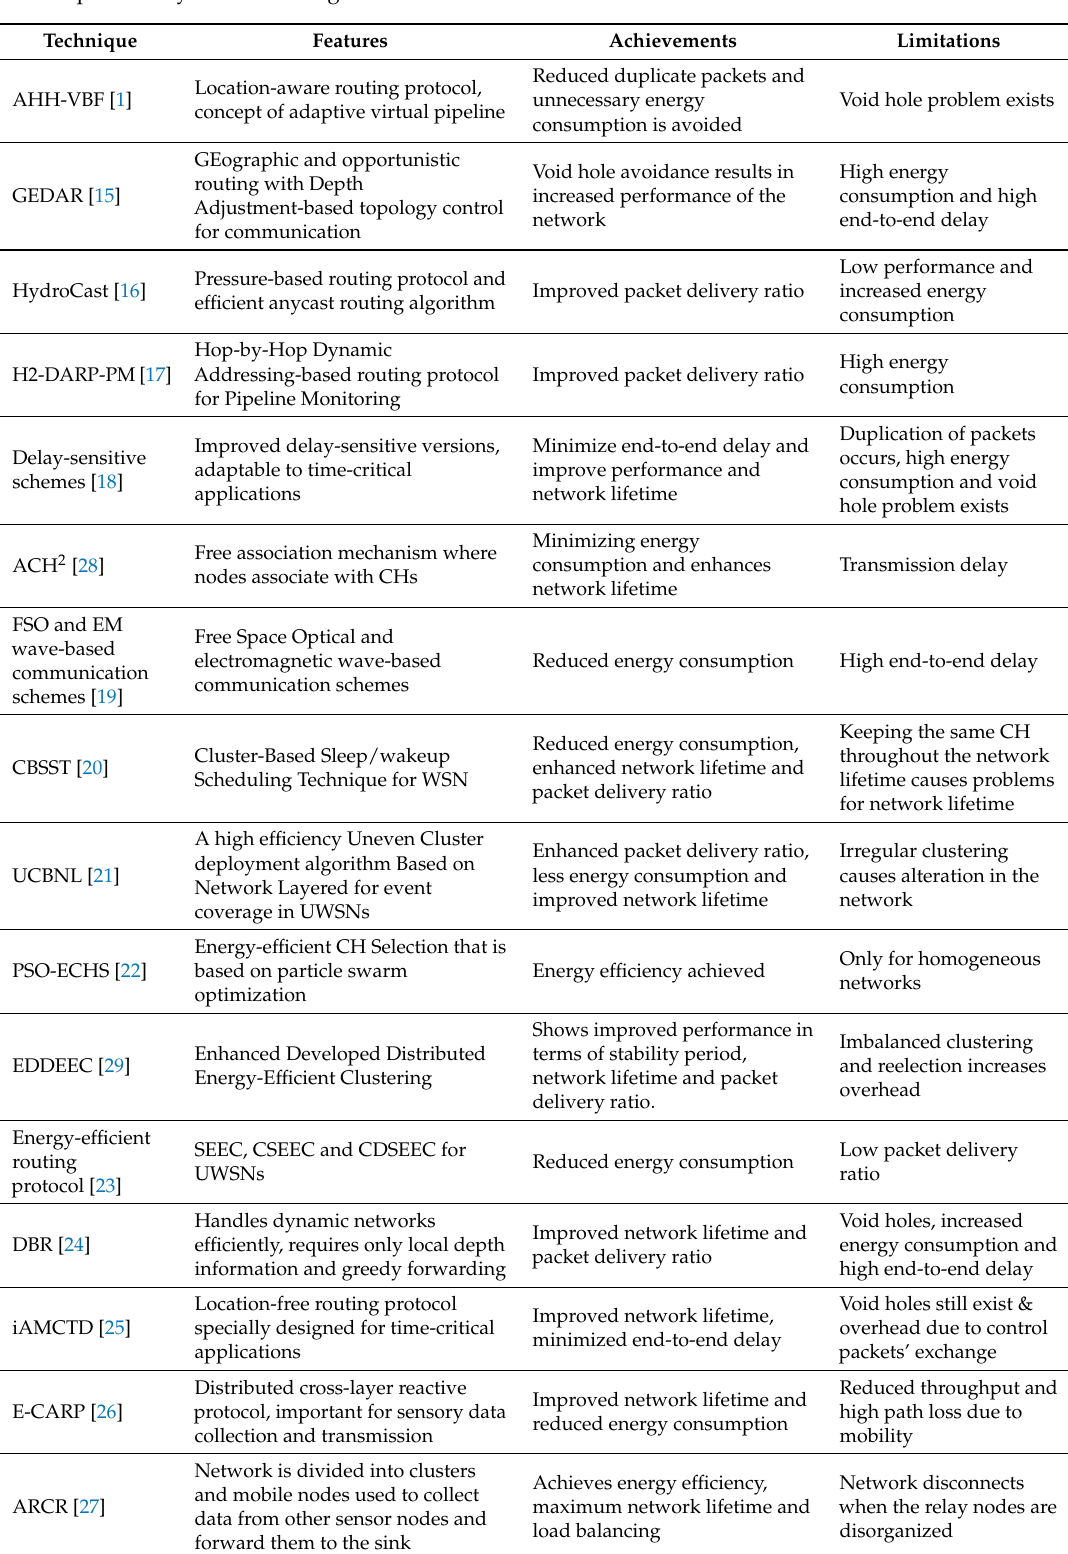
Table 1. Summary of UWSN routing schemes discussed in related work. AHH-VBF, Adaptive Hop-by-Hop Vector-Based Forwarding; HydroCast, Hydraulic-pressure-based anyCast; DBR, Depth-Based Routing; iAMCTD, improved Adaptive Mobility of Courier nodes in Adaptive Relay Chain